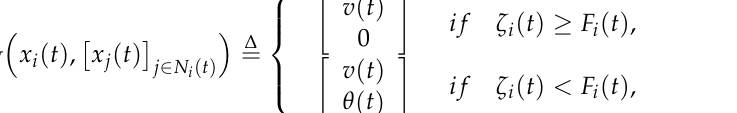
Figure 8. Flowchart of BCCS for coverage.